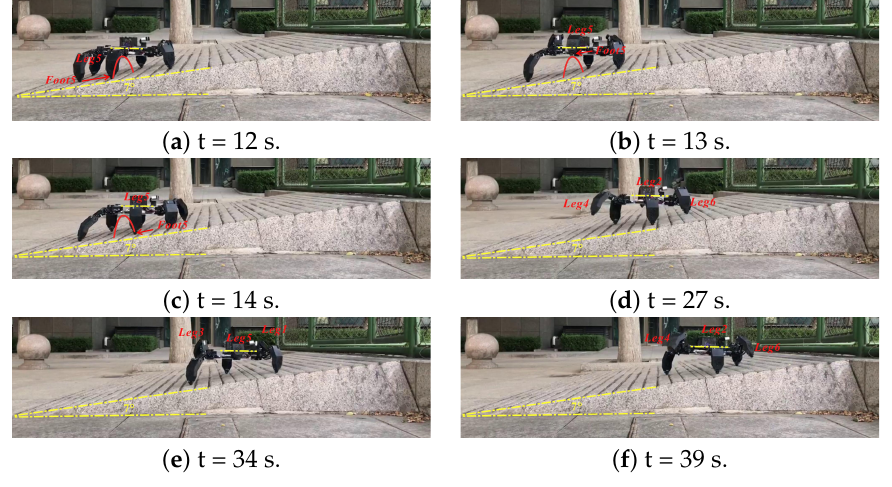
Figure 13. Hexapod robot’s movement on a